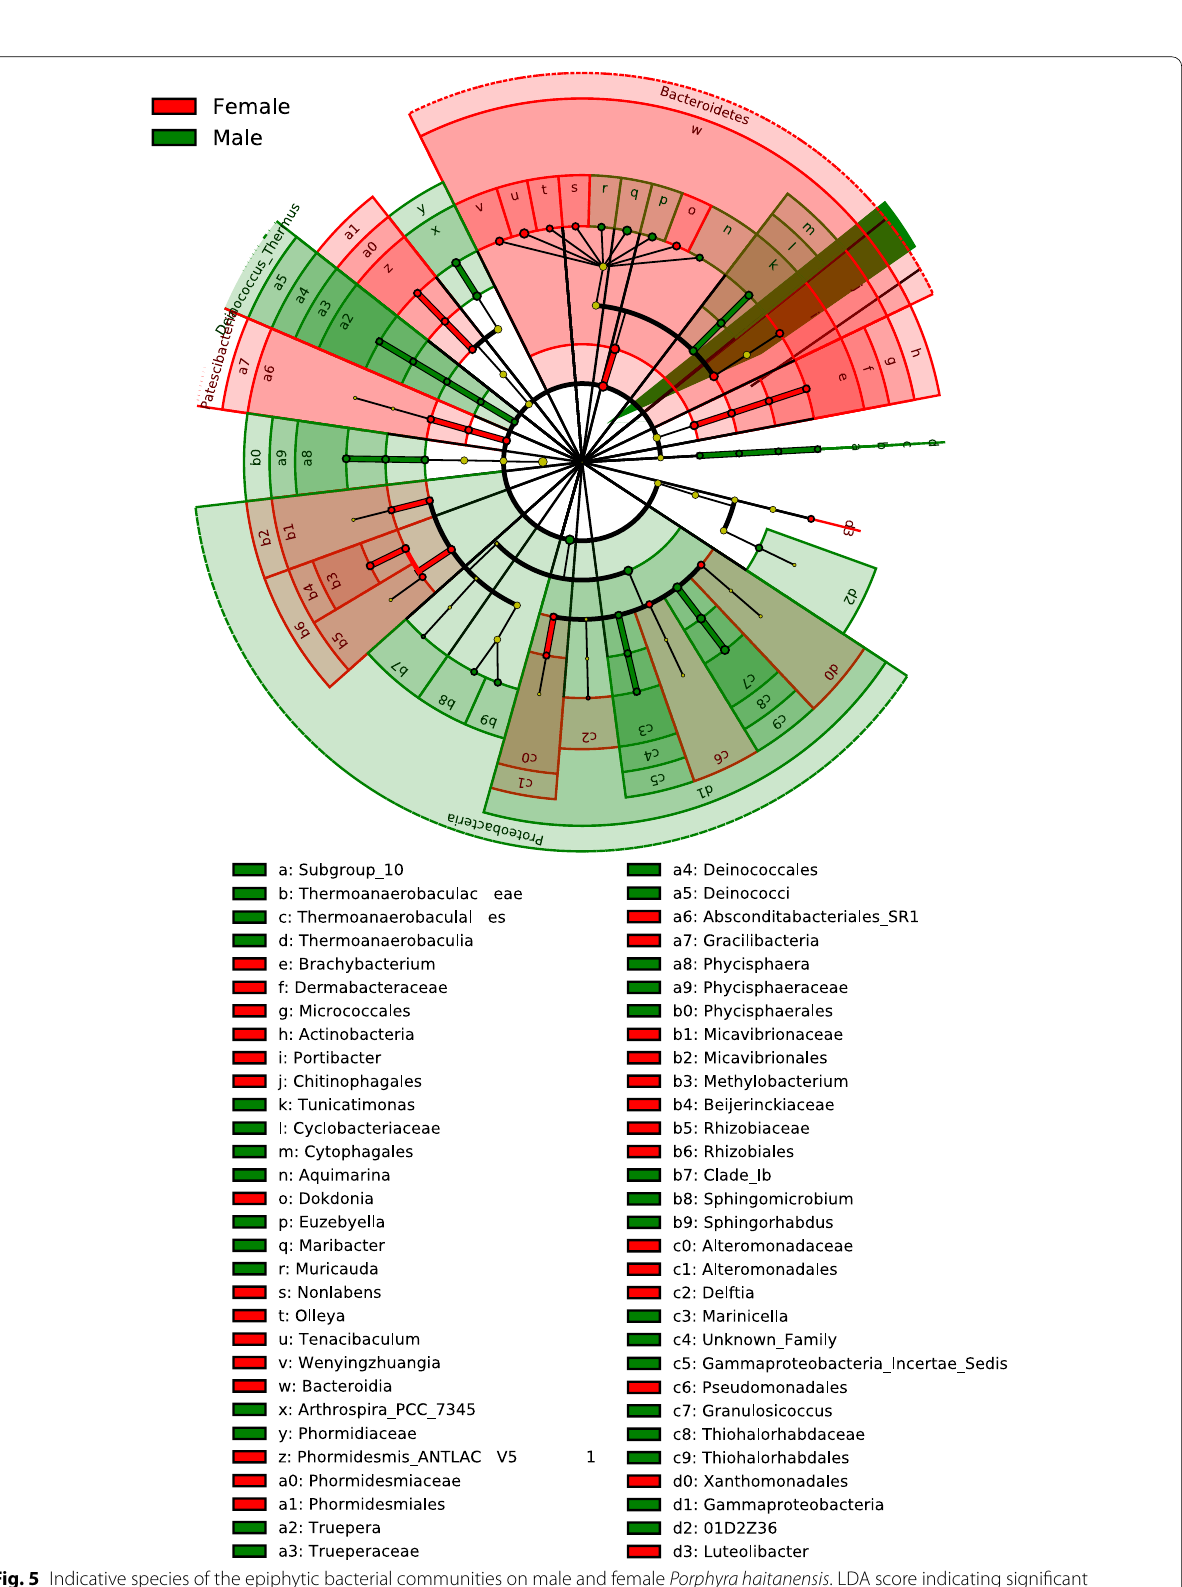
Fig. 5 Indicative species of the epiphytic bacterial communities on male and female Porphyra haitanensis . LDA score indicating significant differences in bacterial taxa (LDA score >